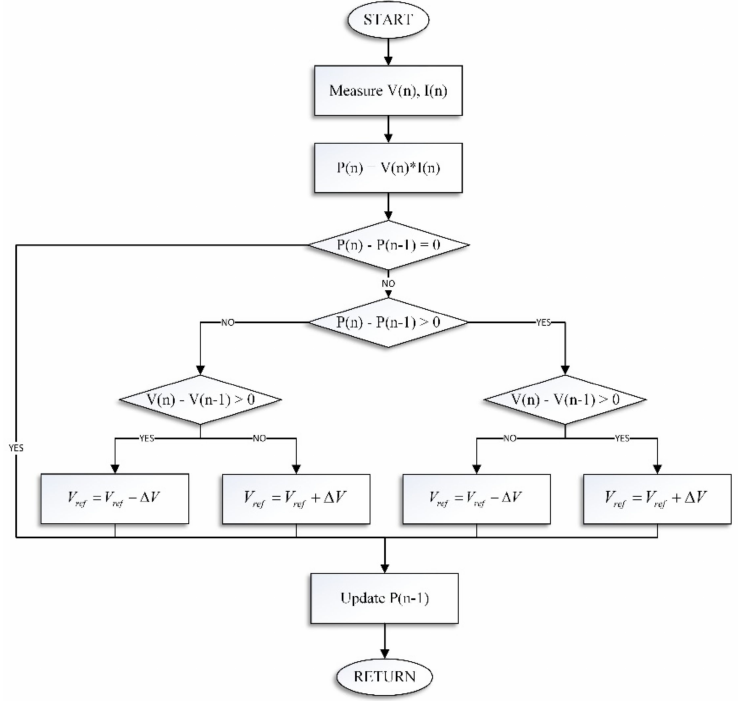
Figure 14. Flow chart of the perturb and observe